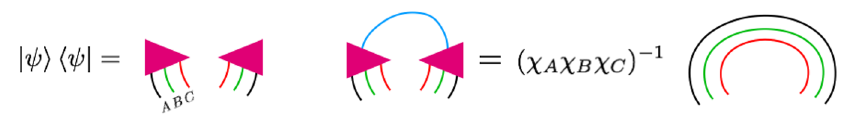
Figure 11 . (Left) The density matrix | ψ i h ψ | is representation by a pair of three-legged tensors, with each leg representing the subspace associated to A, B or C. (Right) An extra factor of ( χ is divided out with each contraction to account for the over all